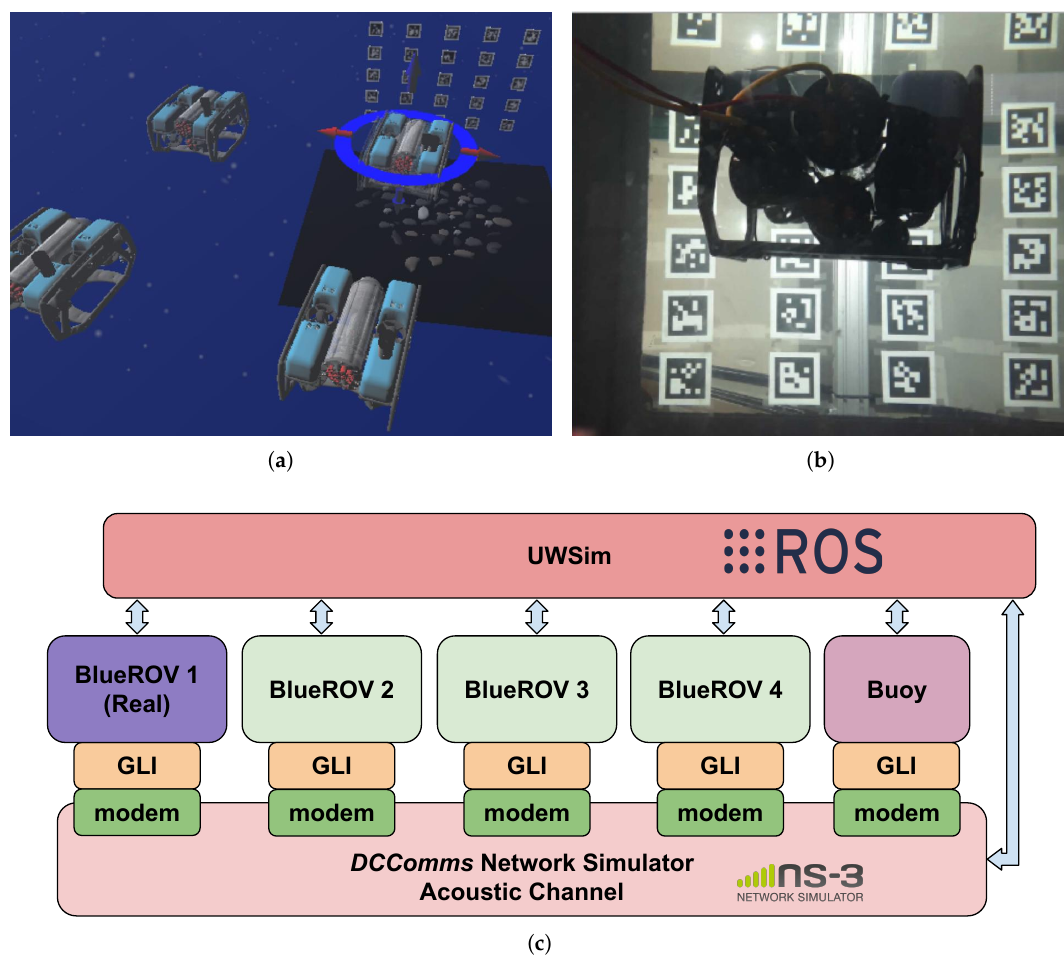
Figure 8. Cooperative AUV Control in HIL. ( a ) UWSim visual interface of the HIL experiment with the four robots. The one with the marker is the real BlueROV. The floor of the water tank and the Aruco markers have also been represented in the UWSim visualization. ( b ) Image of the real BlueROV in the water tank at the IRSLab. ( c ) Block diagram of the elements used in this